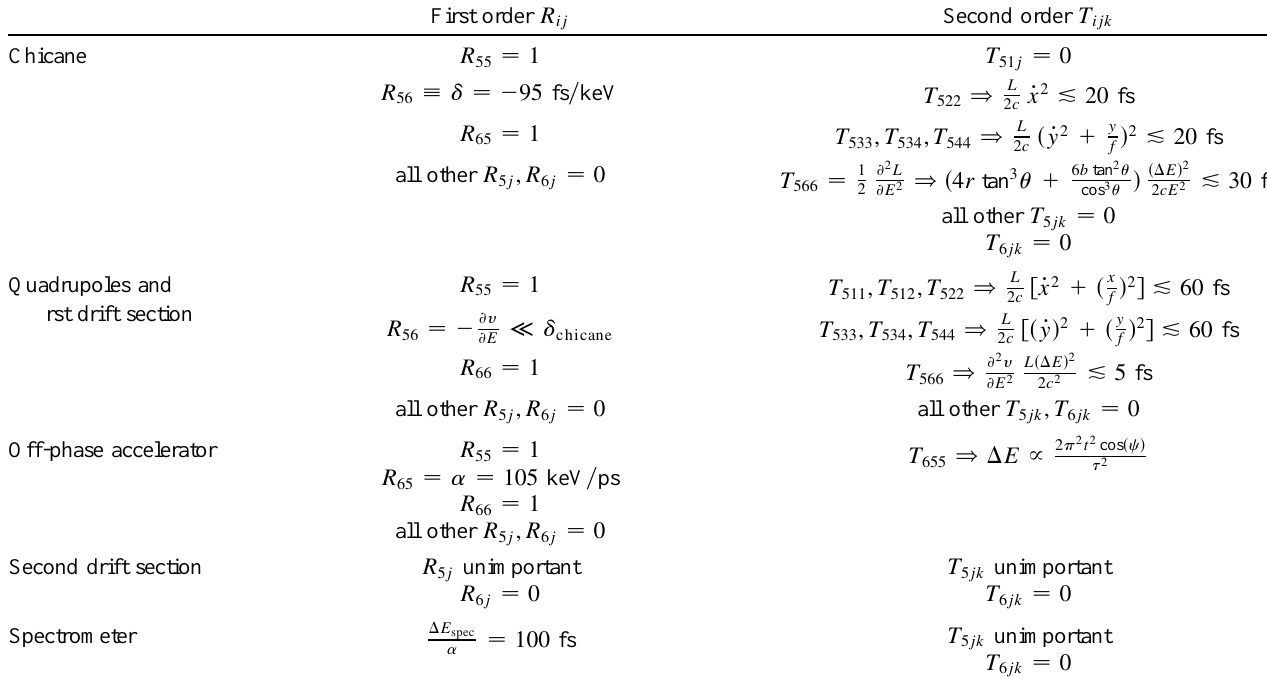
TABLE I. Beam phase-space coupling coefficients for the beam transport used in longitudinal bunch profile measurements. Symbols used are L : effective path length of a beam transport section; f : effective focal length of a magnetic lens or dipole fringe field; b : spacing between chicane dipoles; r , u : bend radius and bend angle in chicane dipoles; y (cid:1) b c : electron drift velocity; t , c : rf period and phase of the off-phase accelerator.